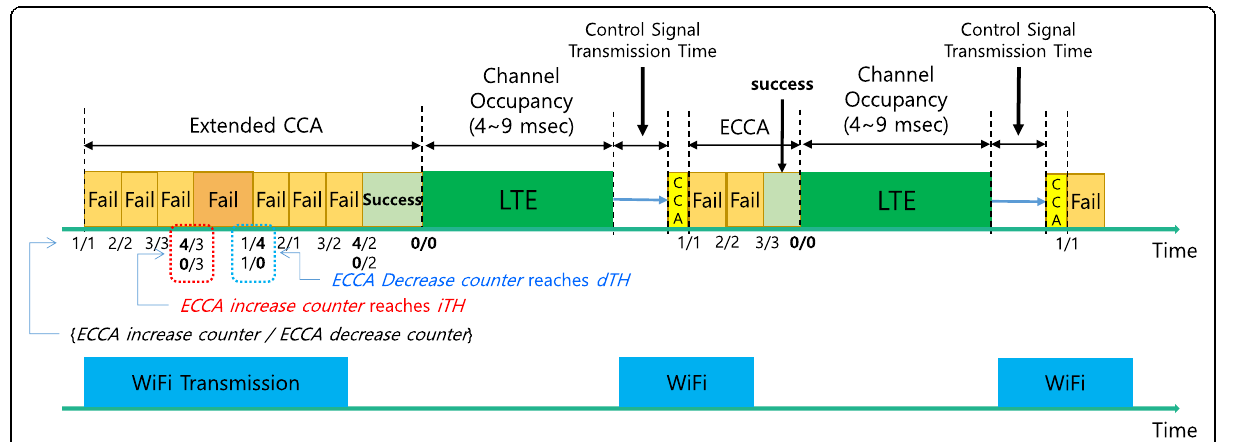
Fig. 4 Example of Action: iTH = dTH =